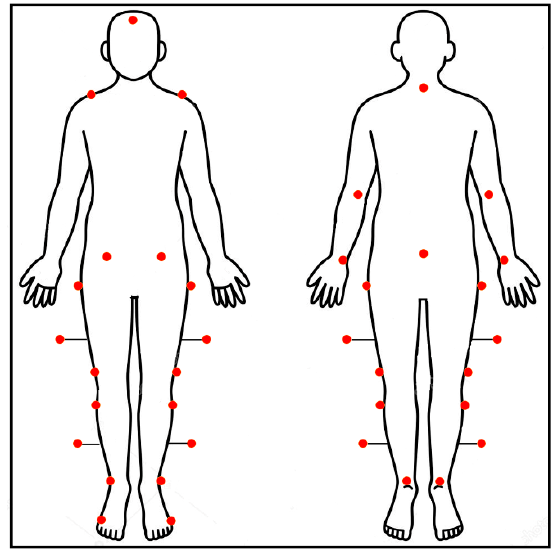
Figure 1. Modified Davis’ protocol for marker placement.